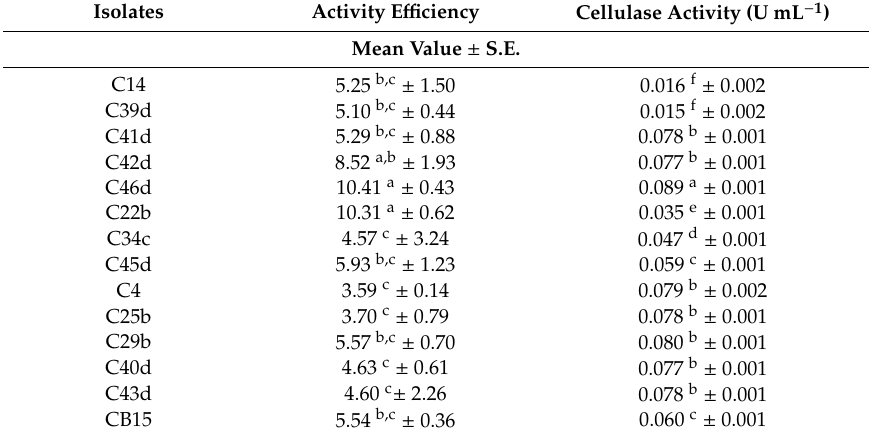
Table 1. Cellulose-hydrolyzing e ffi ciency and cellulase (CMCase) activities (U mL − 1 cell-free culture broth after 5 days at 30 ◦ C, 180 rpm, and medium pH 7) of cellulolytic isolates.